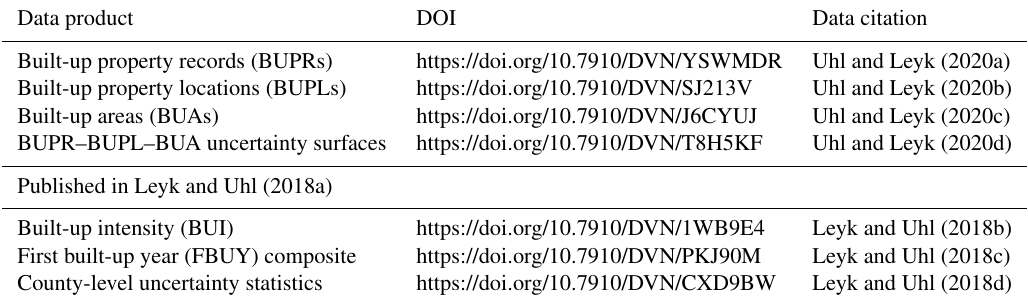
Table 2. Overview of all data products currently contained in the HISDAC-US. Data